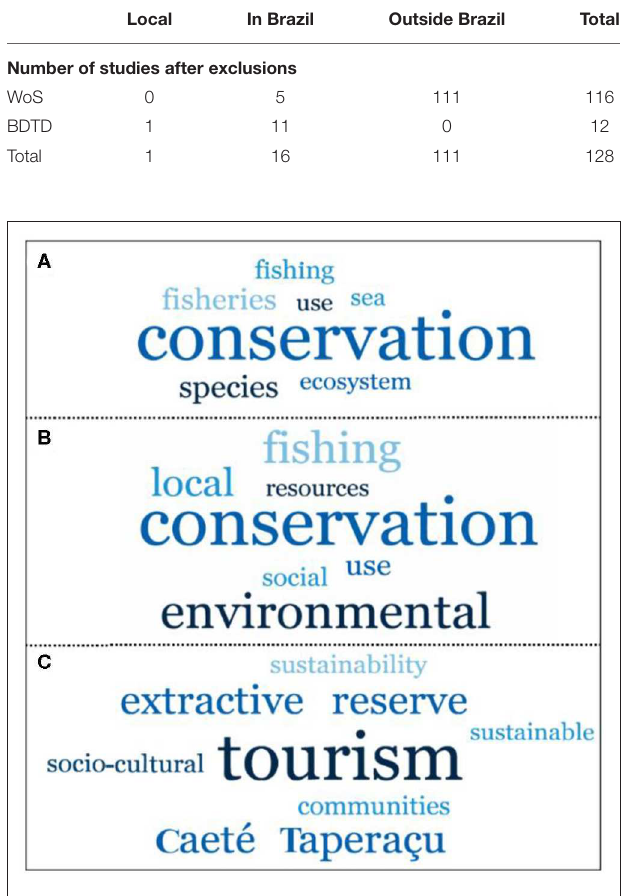
FIGURE 4 | Words with the highest frequencies in the titles of (A) studies outside and (B) in Brazil, and (C) for the local case study. Words/terms are represented in clouds based on their frequency in the studies for the three spatial contexts (international, national, and local). The words with the largest font size are most frequently